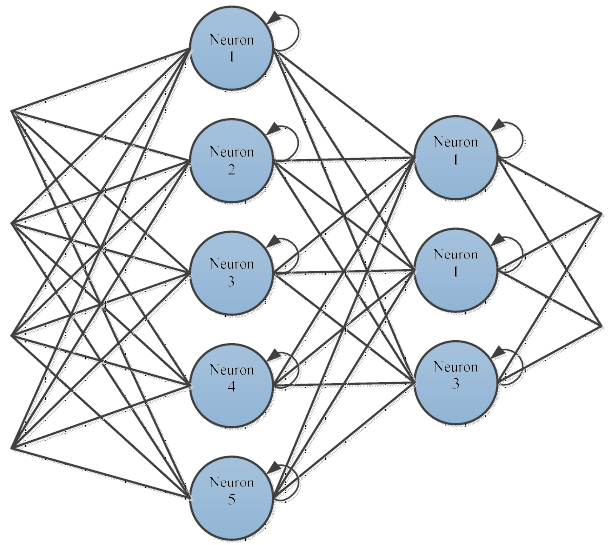
Figure 5. Details of the recurrent neural network architectures network.